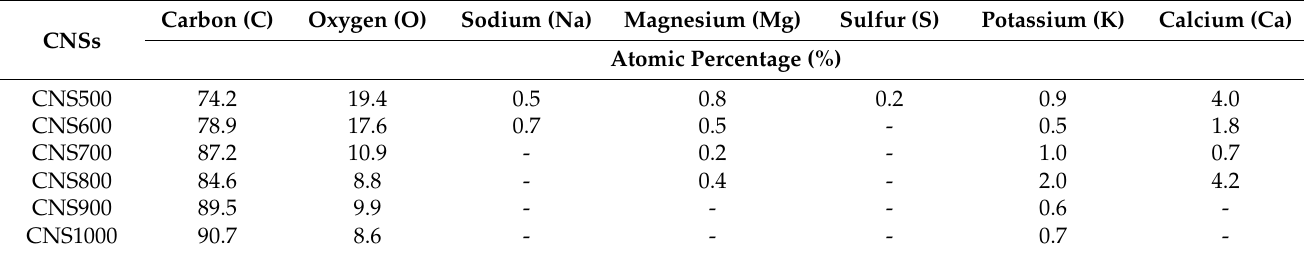
Table 1. Elemental composition (Atomic %) of ON